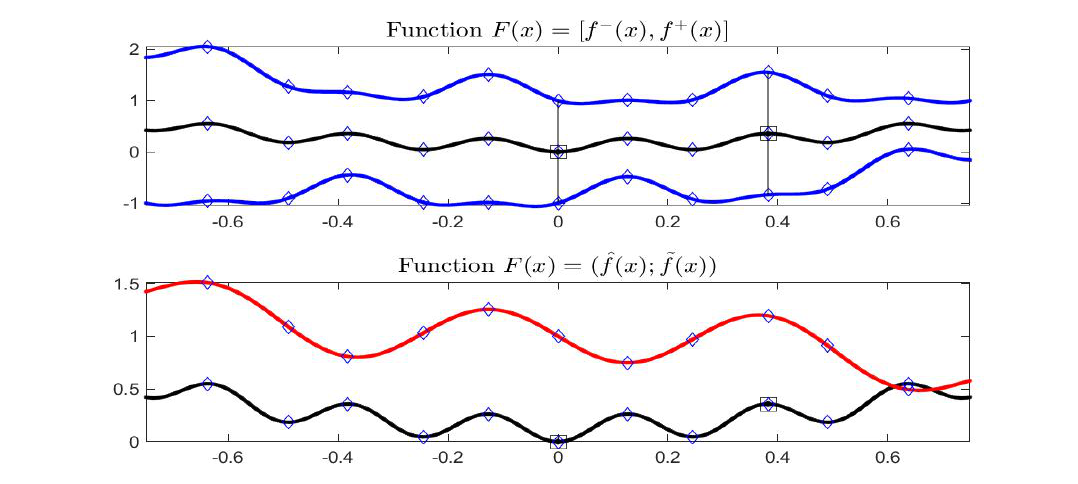
Figure 7. Interval-valued function F ( x ) (top) of the Complete Example. Bottom picture gives functions (cid:98) f ( x ) (black color) and (cid:101) f ( x ) (red).